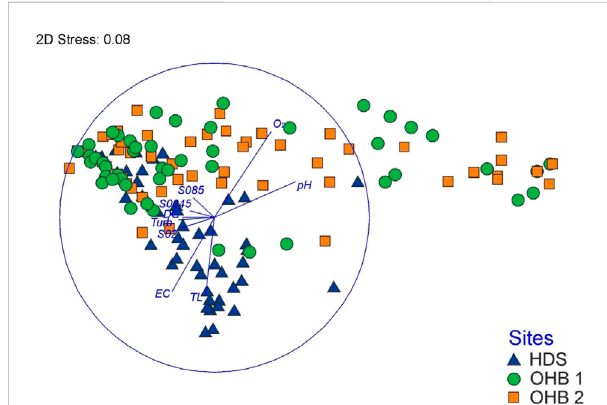
FIGURE 4 Non-metric multidimensional scaling (NMDS) comprising comparisons of egg and larval mortality of the HydroEcoSedimentary Tool (HEST) between the three assessed spawning grounds HDS, groundwater in fl uenced hinterland draining system; OHB 1 and OHB 2, Ottheinrichbach spawning grounds; O 2 , dissolved oxygen [mg · L − 1 ]; pH, pH-value; TL, temperature data [ ° C] from loggers exposedintheHEST;EC,electricconductance[µS · cm − 1 ](correctedto 20 ° C);Turb,turbidity [NTU];DG,meanparticlediameter [mm];S0045, sediment grain size of 0.045 mm; S02, sediment grain size of 0.20 mm; S085, sediment grain size of 0.85 mm. Abiotic habitat variables were correlated on the NMDS ordination plot and are displayed as blue lines. The length of the blue lines is proportional to the degree of correlation with the arrangement of egg and larval mortality (the blue circle = indicates 100% correlation). 2D-Stress, stress value after Kruskal.